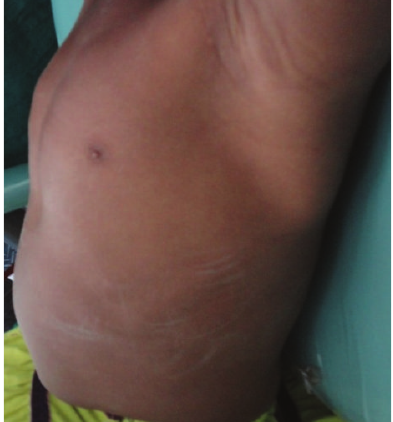
Figure 4: Showing knock